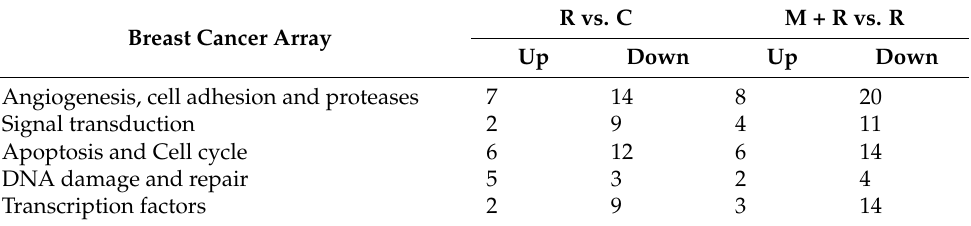
Table 2. This table summarizes the distribution of breast cancer gene categories induced or repressed in MCF-7 cells treated with radiation (8 Gy) (R) or pre-treated with melatonin for one week (1 nM) before being irradiated (M + R). Pathway-focused gene expression profiling was performed using the Human Breast Cancer RT 2 Profiler PCR Array. The number of up- and downregulated genes in each category in comparison to MCF-7 control cells (C) is indicated. R vs. C M + R vs. R Breast Cancer Array Up Down Up Down Angiogenesis, cell adhesion and proteases 7 14 8 20 Signal transduction 2 9 4 11 Apoptosis and Cell cycle 6 12 6 14 DNA damage and repair 5 3 2 4 Transcription factors 2 14